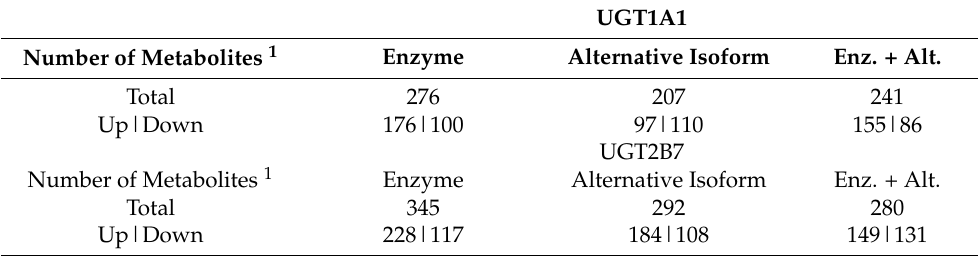
Table 1. Overview of metabolic changes associated with UGT protein expression.